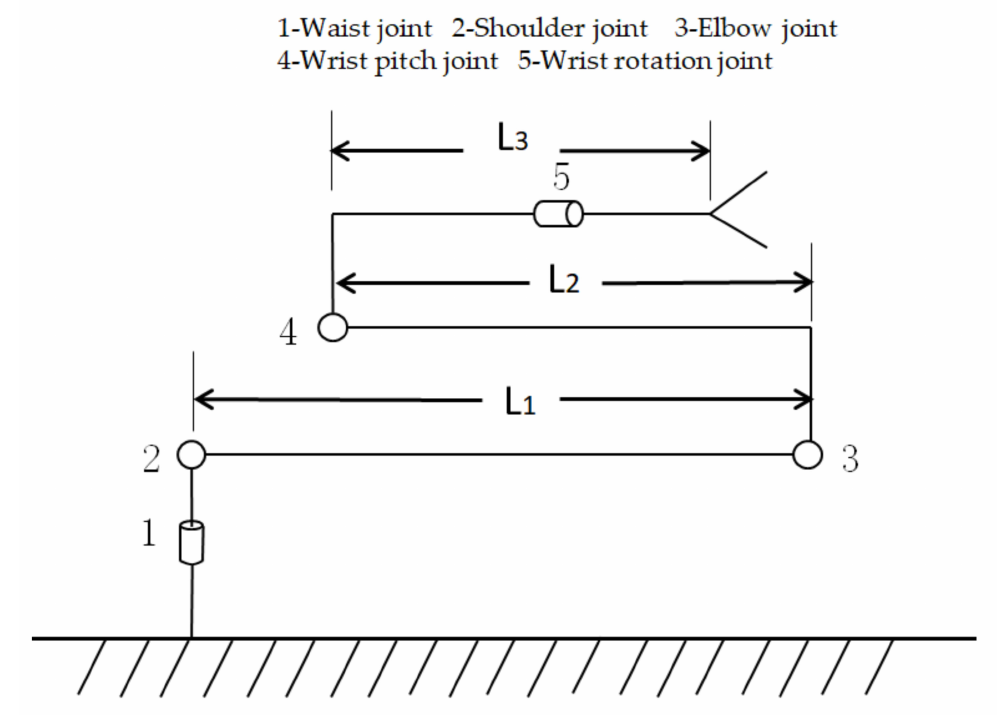
Figure 1. Manipulator configuration